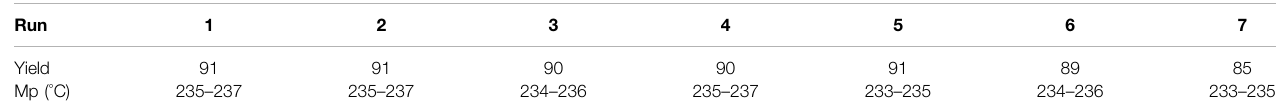
TABLE 4 | Reusability of catalyst in the synthesis of 4a